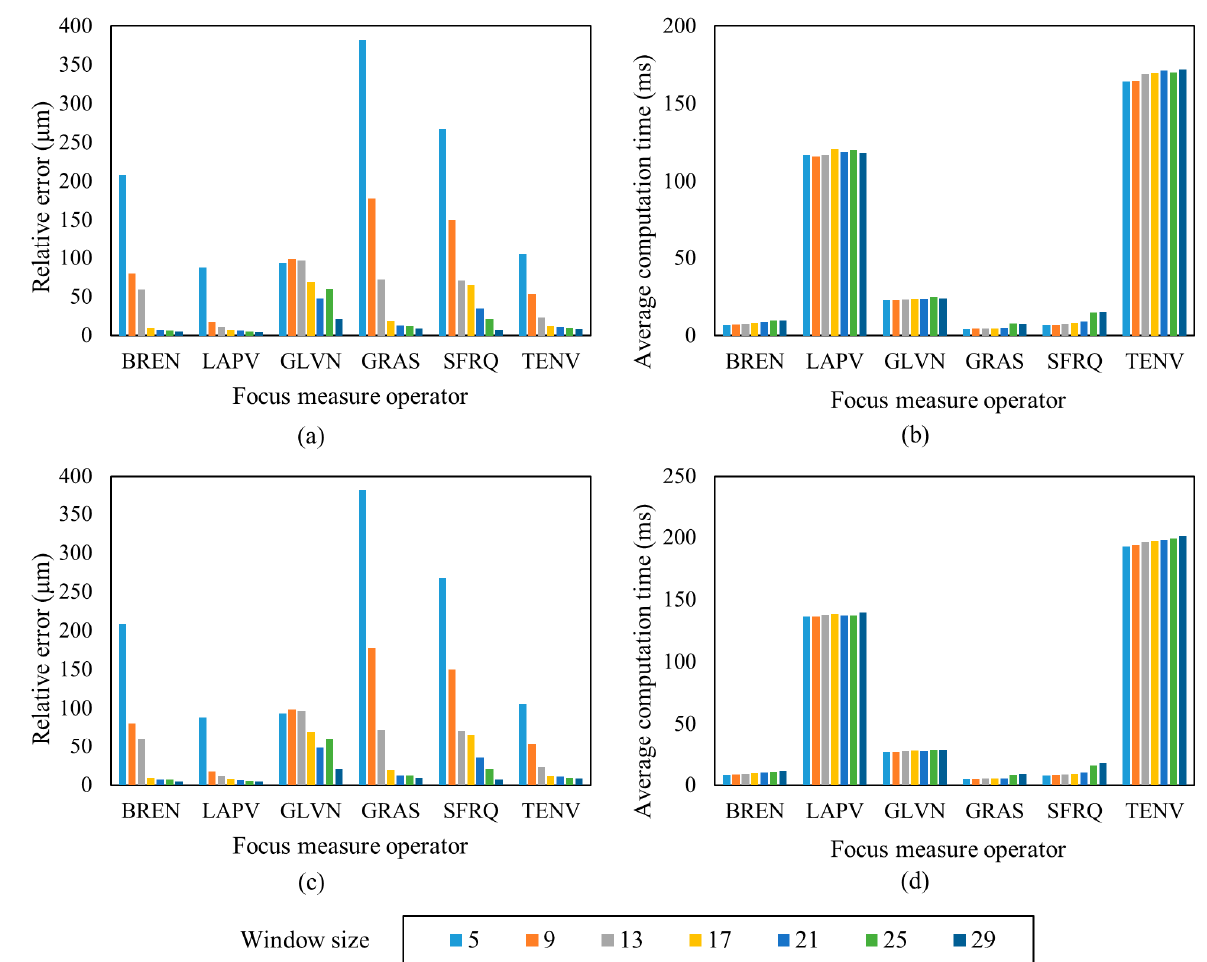
Figure 13. Standard gauge block plane measurement with different focus measure operators and window sizes. ( a ) Measurement error, 1150 µ m standard gauge block; ( b ) Computation time, 1150 µ m standard gauge block; ( c ) Measurement error, 1300 μ m standard gauge block; ( d ) Computation time, 1300 μ m standard gauge block.